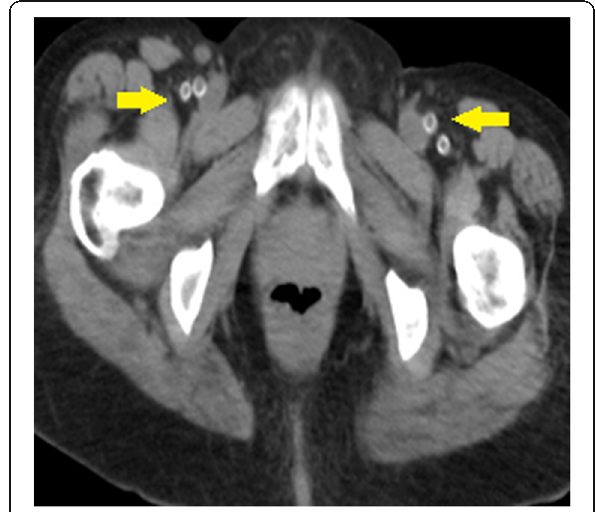
Fig. 2 Non-contrast MSCT examination of the lower limb arterial system for detection and qualification of the arterial wall calcifications showing calcified athermanous plaques at the proximal segments of both deep and superficial femoral arteries on both sides